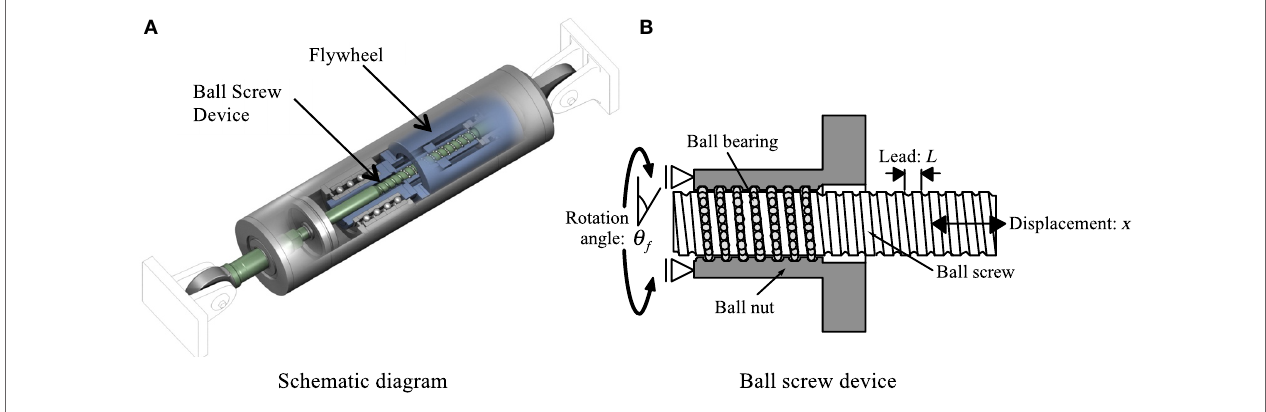
FIGURE 1 | A simple inertial mass damper . (A) Schematic diagram and (B) ball screw device.